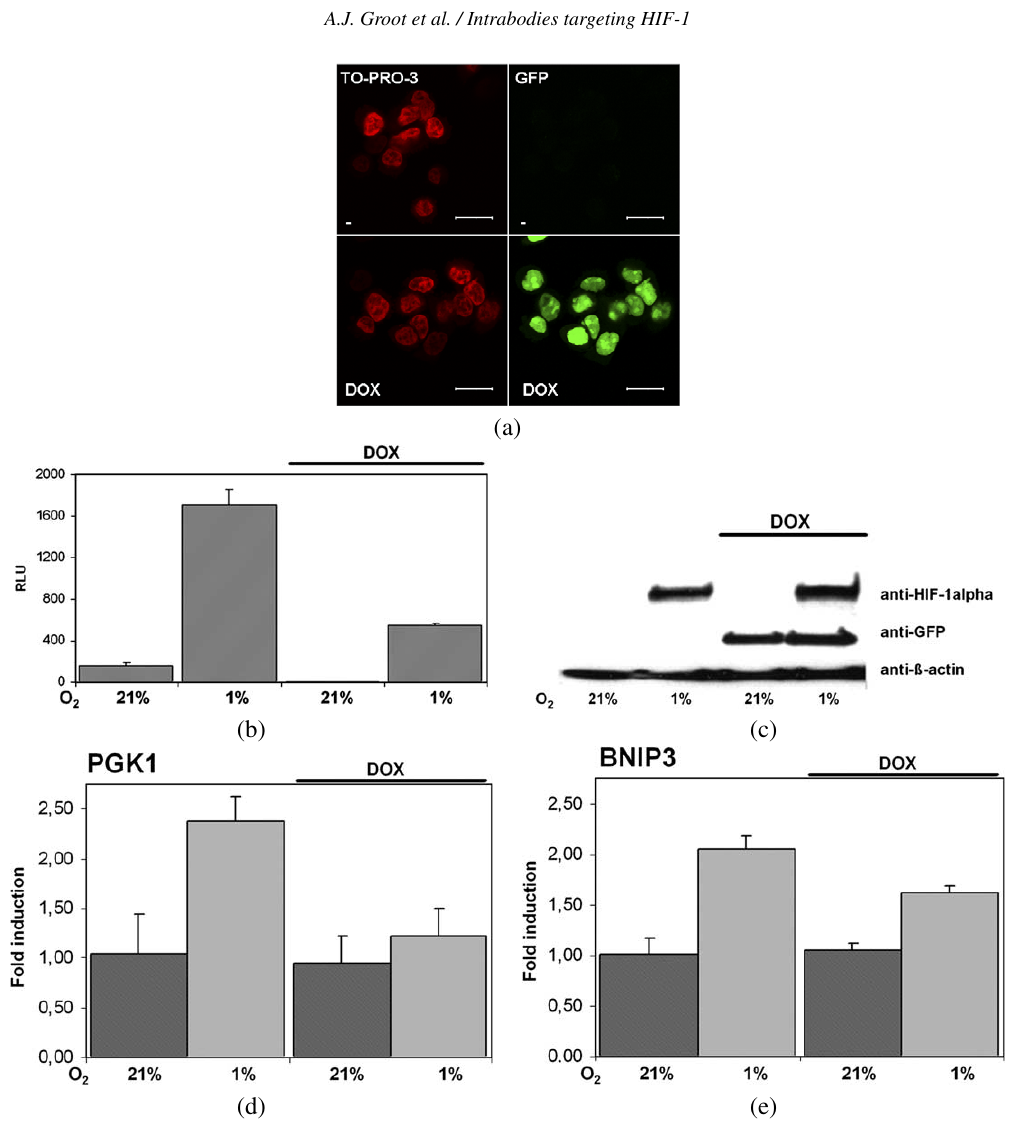
Fig. 6. Functional consequences of intrabody expression. (a) Immunofluorescence confocal microscopy with cultured LS174TR1/IB-AG2 cells with or without doxycyclin (dox), DNA is stained with TO-PRO-3 (dark-grey/red), GFP in green (bright-grey), scale bar = 20 µm. (b) HRE-luc reporter assay in LS174TR1/IB-AG2 cells exposed to normoxic (21%) or hypoxic conditions (1% O 2 ) for 24 h. Luciferase activities in the lysates were measured and expressed as relative light units (RLU). IB-AG2 attenuates hypoxia induced HRE-activity. All luciferase experiments were performed in triplicate. Error bars represent mean + SD. (c) Corresponding immunoblot analyses to (b) of HIF-1 α and IB-AG2 GFP fusion, with β -actin as a loading control. (d, e) LS174TR1/IB-AG2 cells were cultured with or without dox and were exposed to normoxic (21%) or hypoxic conditions (1% O 2 ) for 8 h. Q-PCR for endogenous HIF-1 α targets PGK1 and BNIP3 on prepared cDNA was performed. IB-AG2 inhibits the hypoxic induction of both endogenous targets PGK1 and BNIP3. Experiments were performed in triplicate. Error bars represent mean +